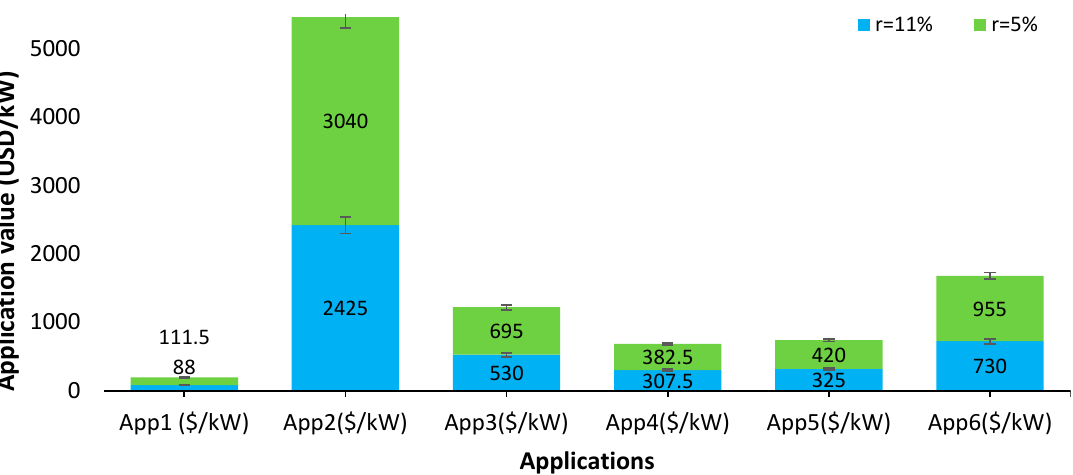
Figure 14. Application value (USD/kW) as a discount rate (%) function.